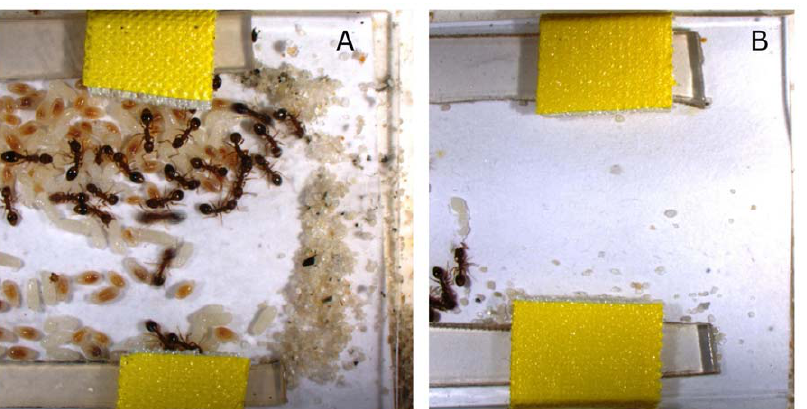
Figure 2. Two T.nylanderi nests representing two extremes of nest reconstruction after partial opening: (A) entrance is almost fully blocked again; (B) entrance is almost unblocked. Entrance blocking should protect better against invasions to the nest.